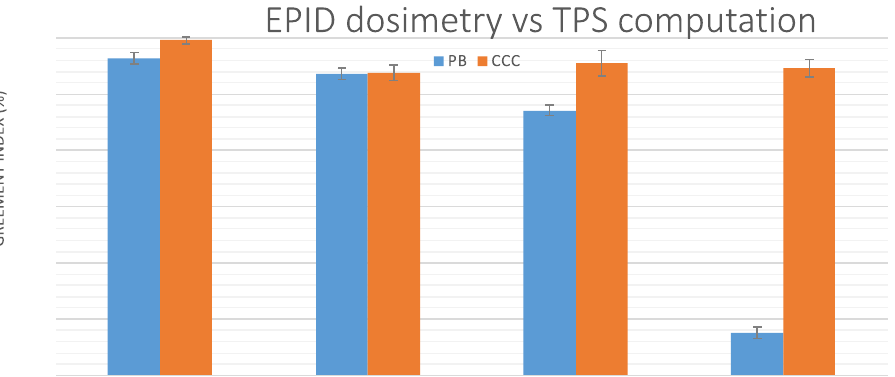
Figure 7. Gamma agreement index at 3%/3 mm local normalization with 10% dose threshold, in the axial slice passing through the isocenter, between the Dosimetry Check doses reconstructed with the two algorithms, pencils beam (PB) and Collapsed Cone Convolution (CCC), and the planned doses computed by the treatment planning system (TPS).